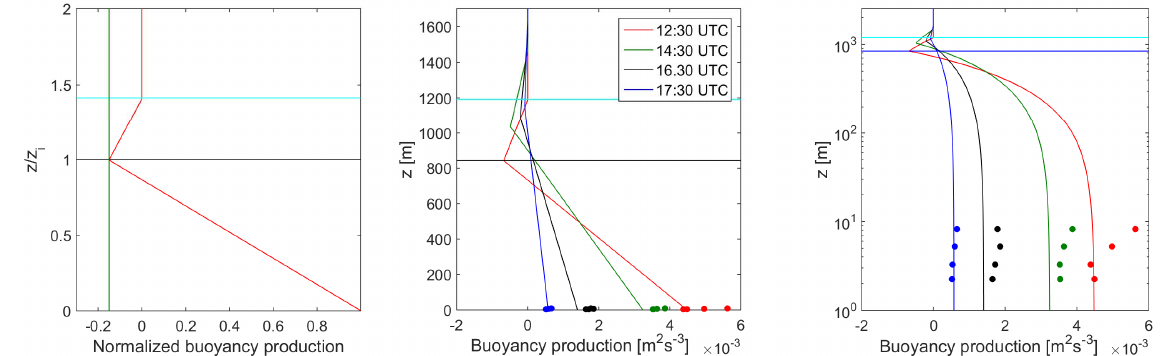
Figure 2. The left panel shows the simple modeled height dependence for the buoyancy production term in the TKE budget normalized by the surface value (in red). A vertical green line is added at − 0 . 15, which is the entrainment parameter value. A horizontal black line indicates the boundary layer depth z i defined from smoothed lidar measurements, whereas the horizontal light-blue line indicates z i 0 , the height of no turbulence. The middle panel shows an example of the evolution of the vertical profiles during the afternoon of 20 June. Measurements corresponding to the hourly averaged budget results for the four heights on the small tower are shown as colored dots. Boundary layer height z i and height of no turbulence z i 0 for 12:30UTC are shown as horizontal black and light-blue line. The right panel corresponds to the middle panel but shows the model and data on a semi-logarithmic scale to better display the near-surface